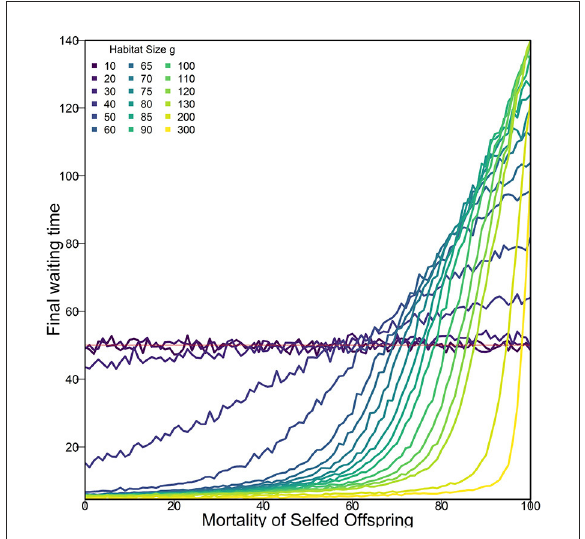
FIGURE5 Average final (last day) WT with fixed mortality of selfed offspring after 30,000 days (number of days used in Figure 3). The dark (purple) lines indicate habitat size g where WT evolved due to drift alone. This line remains close to 50 (marked by red line), independently of mortality of selfed offspring. Therefore, the point where this line is crossed marks the minimum ID needed to achieve an increase in WT within this number of days for a given density. Simulations used default parameters as shown in Table 1 except offspring viability for selfing and outcrossing was not determined by genes. Each datapoint represents one set of 300 replicates (except for g = 300 and Mortality = 100, where only 175 populations persisted 30,000 days) with a given